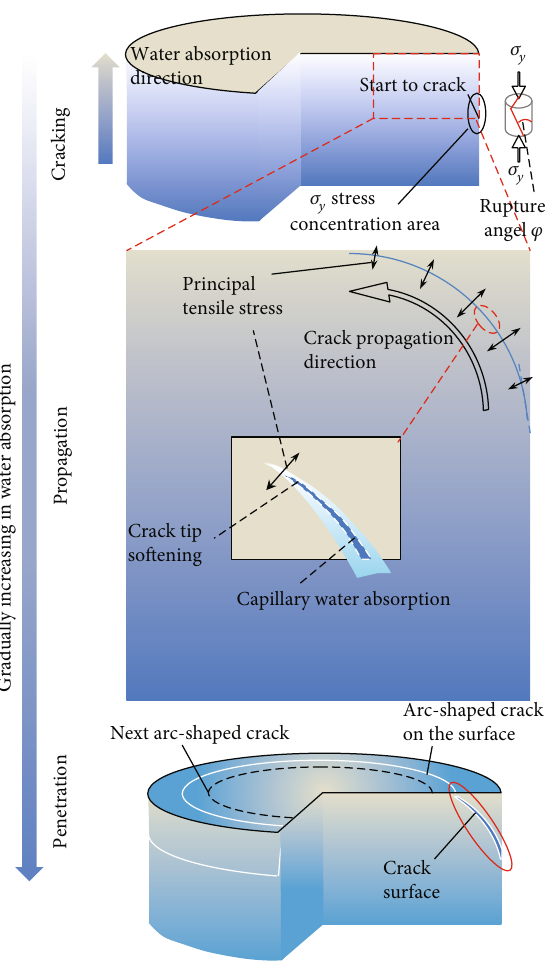
Figure 21: Processing of crack development.